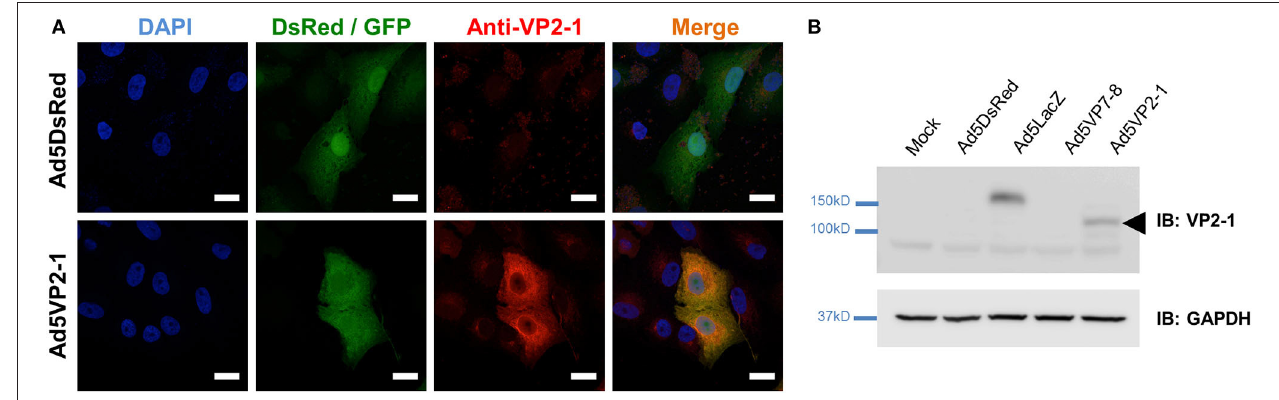
FIGURE 1 | VP2-1 protein is expressed in Ad5VP2-1-infected Vero cells. (A) Representative immunofluorescence confocal images of Vero cells infected with Ad5DsRed or Ad5VP2-1 (MOI 1) and stained with anti-VP2-1 polyclonal rabbit sera (shown in red). Reporter fluorescent proteins expressed by the Ad5DsRed (DsRed) or Ad5VP2-1 (GFP) constructs are shown in green. 4 ′ ,6-Diamidino-2-phenylindole (DAPI) was used to counterstain for nucleic acids (blue). Scale bar = 20 µ m. (B) Western blot of Vero cells mock-infected or infected with Ad5DsRed, Ad5LacZ, Ad5VP7-8, or Ad5VP2-1. PVDF membranes were immunoprobed (IB) with anti-VP2-1 polyclonal rabbit sera or anti-GAPDH antibody (as sample loading control). Arrowhead indicates the presence of VP2-1 in the Ad5VP2-1-infected cells at the predicted molecular weight of the